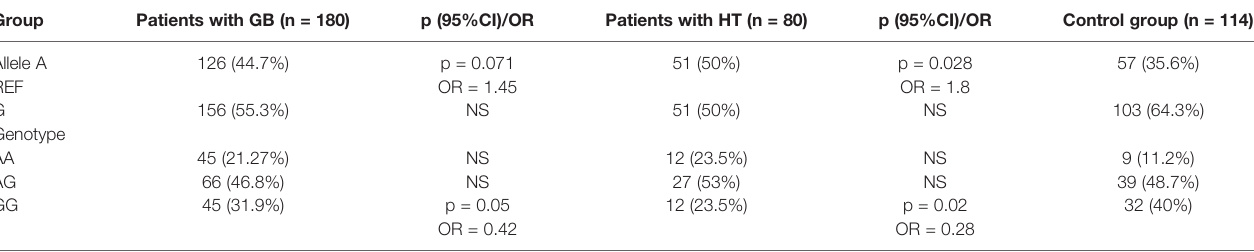
TABLE 3 | Genotype and allele frequencies for FAIM2 gene polymorphism (rs7138803) in groups with Graves ’ disease (GD) and with Hashimoto ’ s thyroiditis (HT) compared to control group. Group Patients with GB (n =